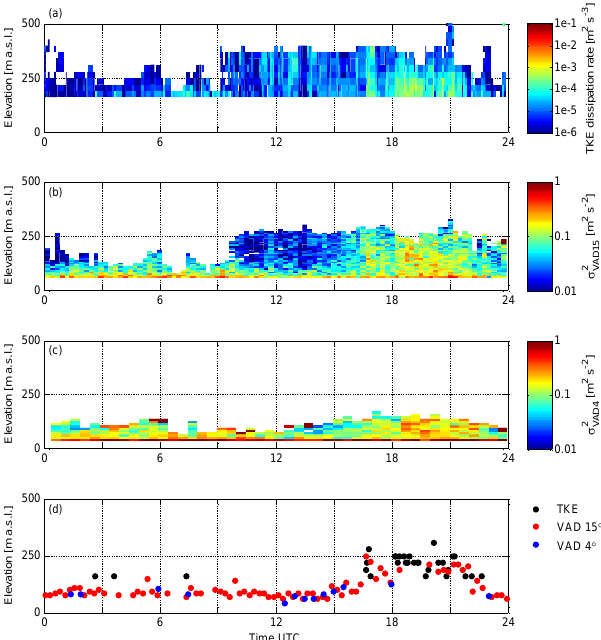
Figure 7. Diurnal variation at Loviisa on 27 December 2013 of (a) TKE dissipation rate, (b) σ 2 from 15 ◦ elevation angle VAD, (c) VAD σ 2 from 4 ◦ elevation angle VAD and (d) VAD